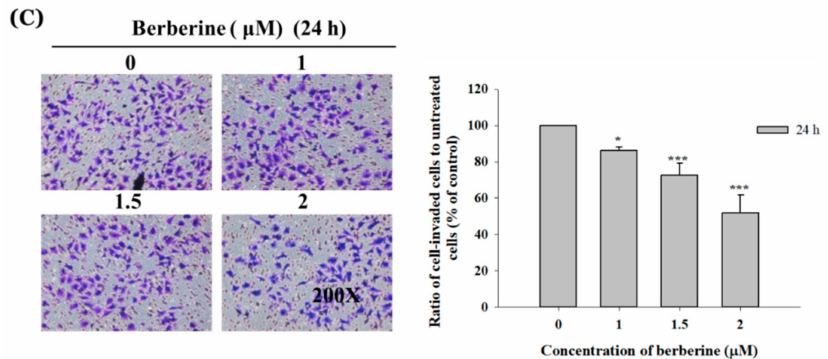
Figure 3. The berberine inhibited the matrix metalloproteinase (MMP) activity and suppressed the migration and invasion of A375.S2 cells in vitro. The cells (1 × 10 5 cells/well) were incubated in 12-well plates and treated with different berberine concentrations (0, 1, 1.5, and 2 µ M) for 12 and 24 h. Then the conditioned mediums were harvested for gelatin zymography assay ( A ) as described in Materials and Methods. The cells (5 × 10 4 cells/well) were placed on transwell inserts coated with collagen for migration or with Matrigel for invasion and were treated with different berberine concentrations (0, 1, 1.5, and 2 µ M) for 24 h. The A375.S2 cells penetrated to the lower surface of the transwell membrane for migration ( B ) or invasion ( C ) stained with crystal violet and photographed under a light microscope at 200 × . The penetrated cells were counted as described in Materials and Method. The results were obtained from the three independent experiments. * p < 0.05, *** p < 0.001, significant difference between berberine-treated groups and the control as analyzed by one-way ANOVA analysis of